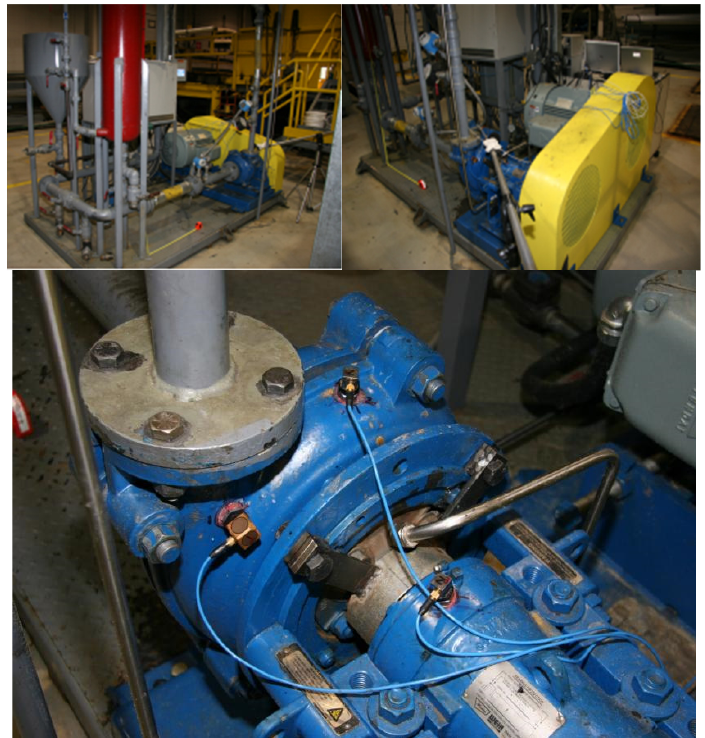
Figure 3. Experimental system of slurry pump with multiple channel sensors.